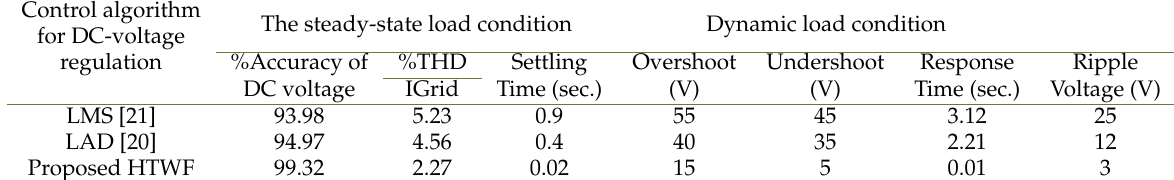
Table 1. Comparison of LMS, LAD and HTWF based control